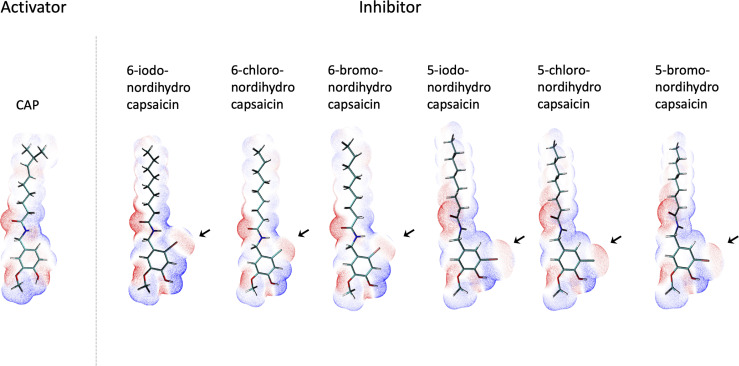
Electrostatic potential maps of capsaicin and halogenated capsaicin analogs.Electrostatic potential maps of capsaicin and halogenated capsaicin analogs (Br, Cl, I – at either five or six position) were generated using MultiWFN. Red represents more electronegative regions and blue represents more electropositive.